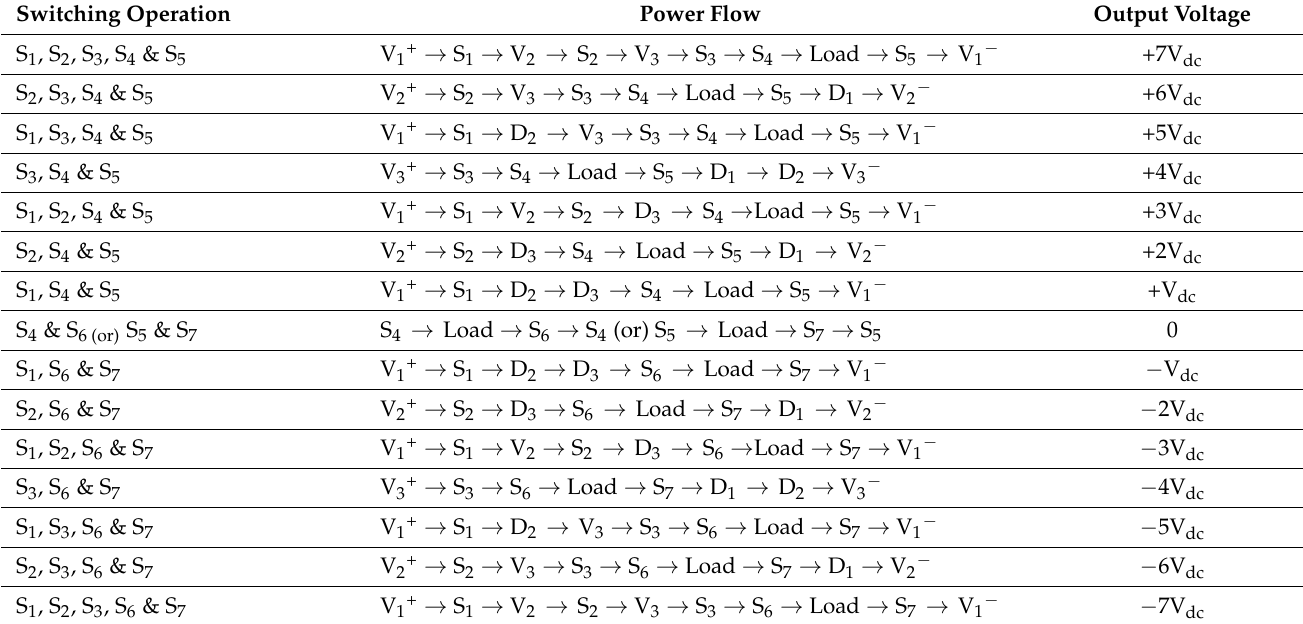
Table 2. ON switches, power flow paths, and corresponding output levels of proposed 15-level